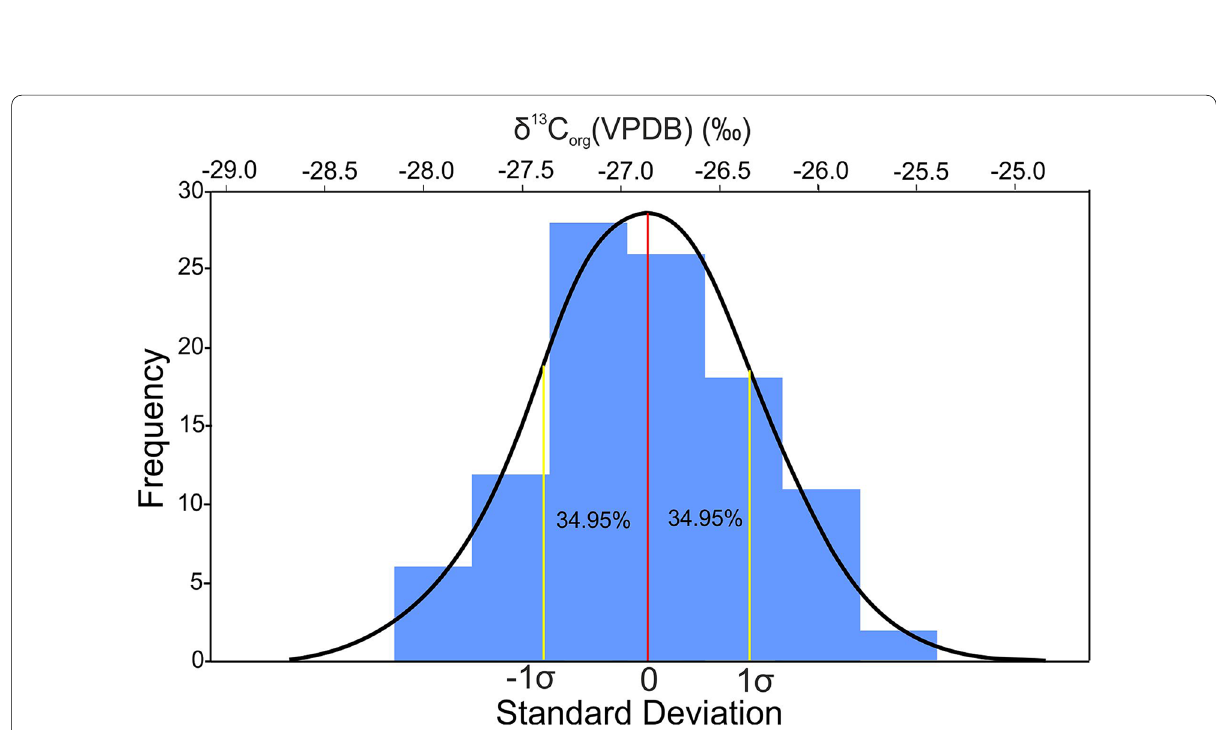
Fig. 7 Histogram showing the frequency distribution of bulk sediment organic matter δ 13 C values. Red line marks the mean value ( Yellow lines demarcate the standard deviation (1 σ